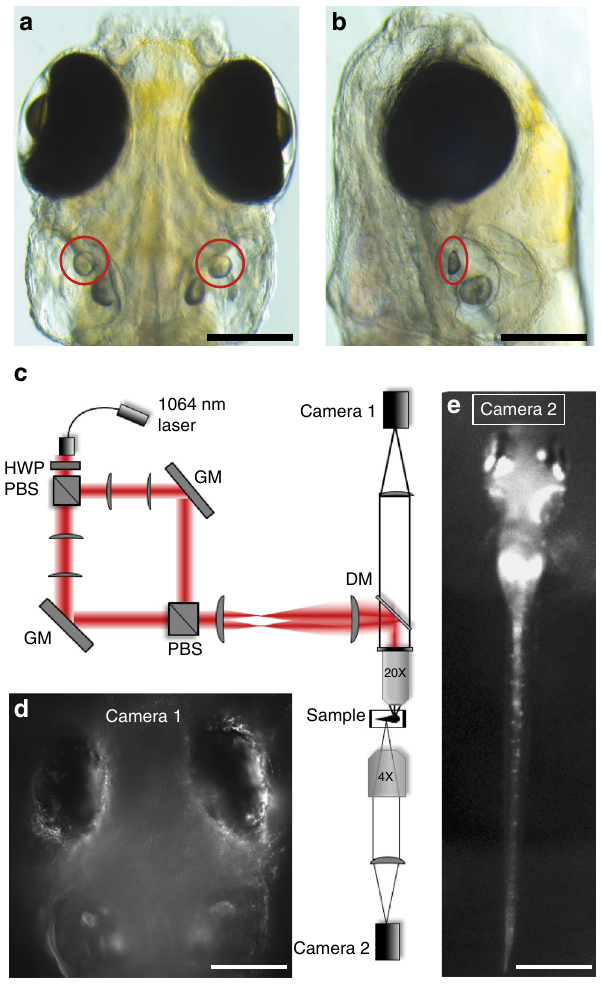
Fig. 2 Optical setup for otolith OT and behavioural imaging. Dorsal ( a ) and lateral ( b ) views, indicating the location of the utricular otoliths ( circles ) in a 6dpf zebra fi sh larva ( scale bars , 200 µ m). c Experimental set up (see Supplementary Methods for details) for delivering a dual OT to the